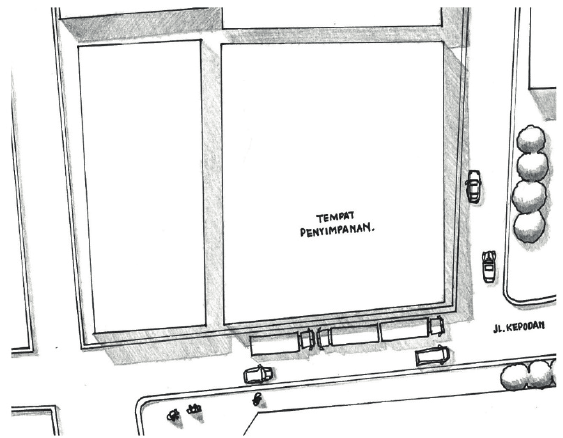
Fig. 7. The Bird View of Road Infrastructure as the Logistic Supporting Aspect at Suari Street, Kota Lama Semarang